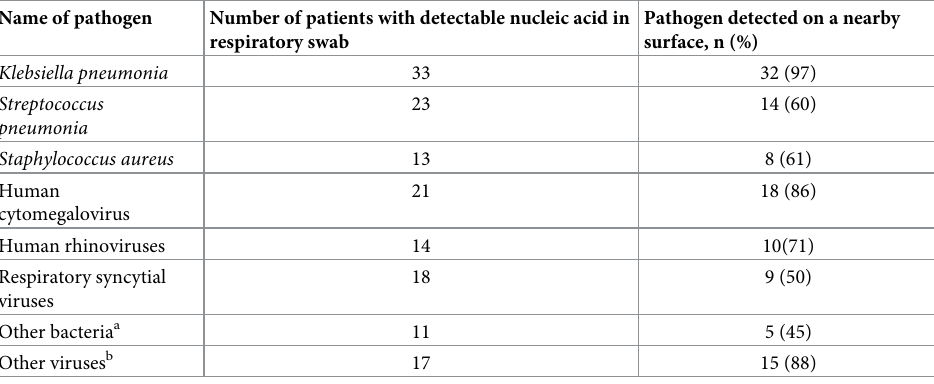
Table 2. Frequency of surface contamination with detectable nucleic acid for specific pathogen near patients with detectable nucleic acid in respiratory swab of the same pathogen, in two tertiary care hospitals in Bangladesh, Sep- tember-November,